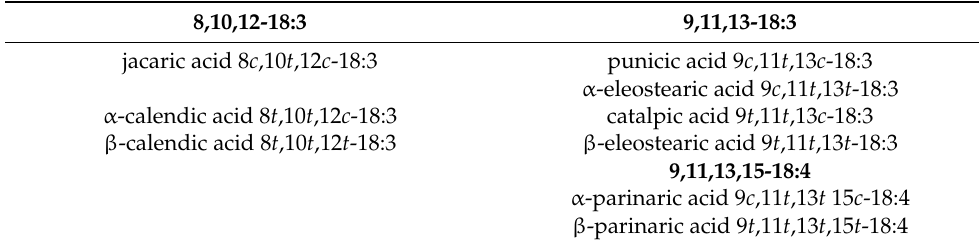
Table 1. Common names and configurations of conjugated 18:3 and 18:4 fatty